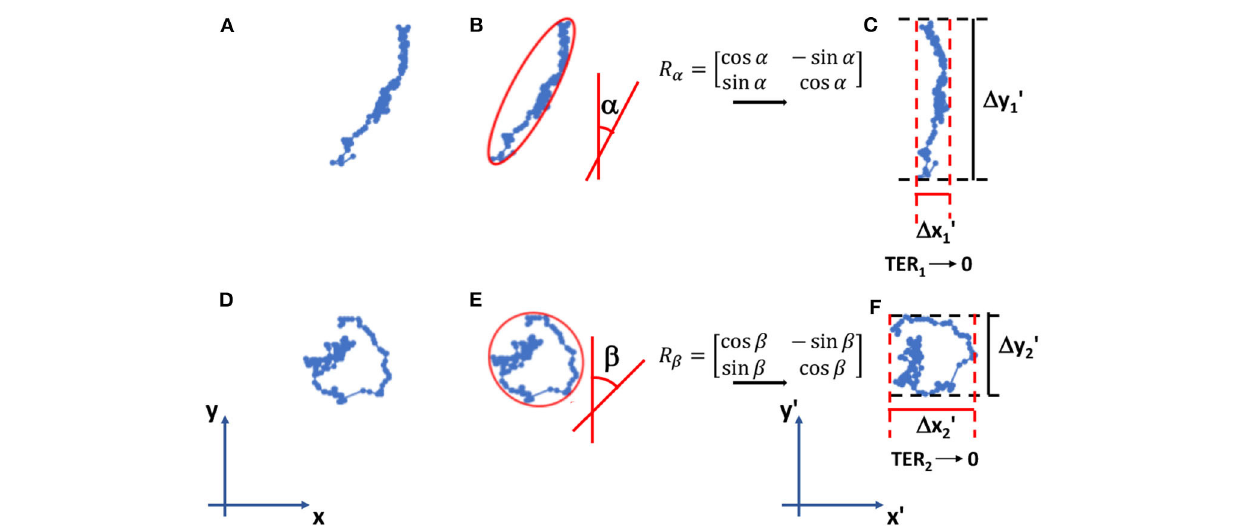
FIGURE 1 | Examples of cell trajectories (A–D) in the reference system. Their orientations α and β are calculated using the fitting-ellipse function in Image J (B–E) and then the rotation matrices R α and R β rotate the trajectories in the new reference system x ′ -y ′ (C–F) . Here, we calculate TER parameter as indicated in formulas (1)–(3). TER 1 approaches to 0 (elongated trajectory), whereas TER 2 is close to 1 (round/random